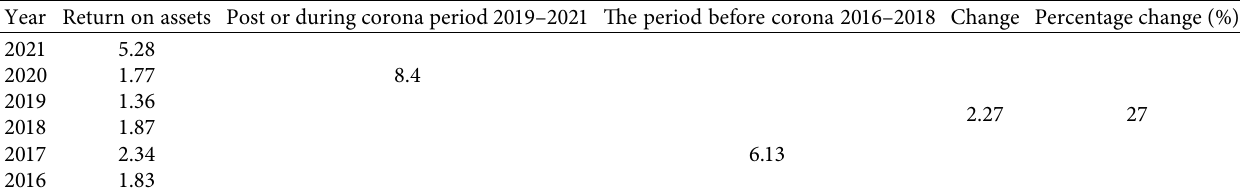
Table 6: Te development of return on assets of the study sample companies before and after the efects of the Corona pandemic. Year Return on assets Post or during corona period 2019–2021 Te period before corona 2016–2018 Change Percentage change (%)